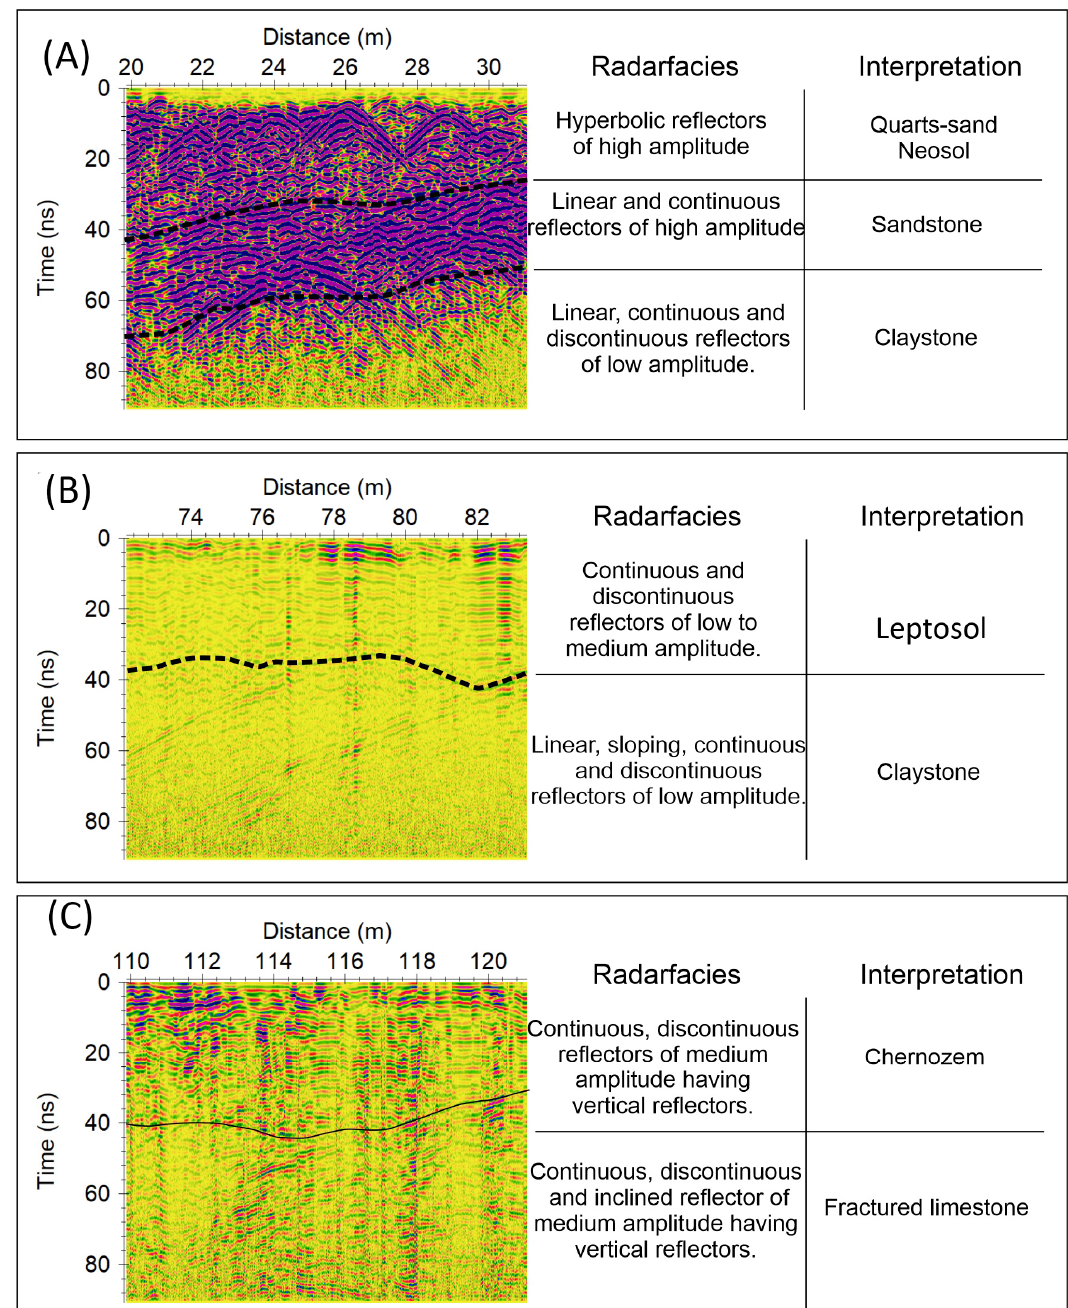
Figure 9. The prominent radar typologies. Zoomed images of di ff erent radar images along with the possible lithofacies shown in Figure 8. ( A ) High amplitude reflections associated with sandstone and Neosols, ( B ) low energy reflections may indicate the presence of conductive material possibly Leptosols and claystone and ( C ) intermediate amplitude reflections (energy) indicate the presence of